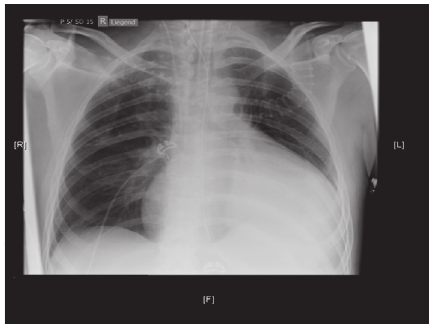
Figure 2: Chest radiograph (anteroposterior view) shows no pul- monary infiltrates or effusions, no pneumothorax, and no cardiac congestion but an enlarged heart with a water-bottle